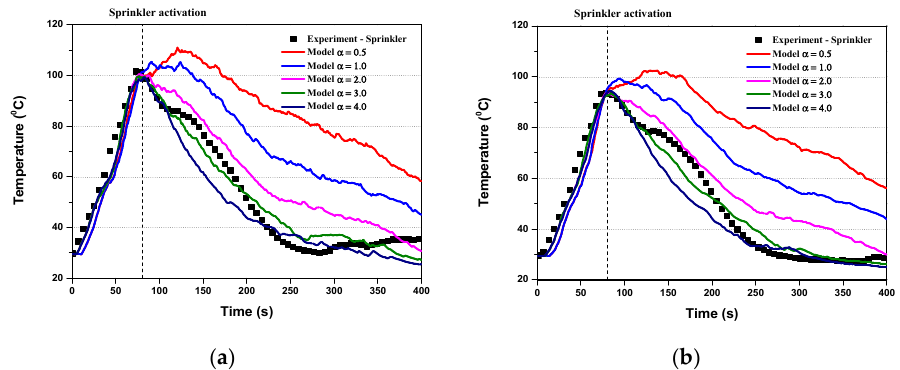
Figure 6. Variation of ceiling temperature with different extinguishing coefficients: ( a ) Point 1 and ( b ) Point 2.